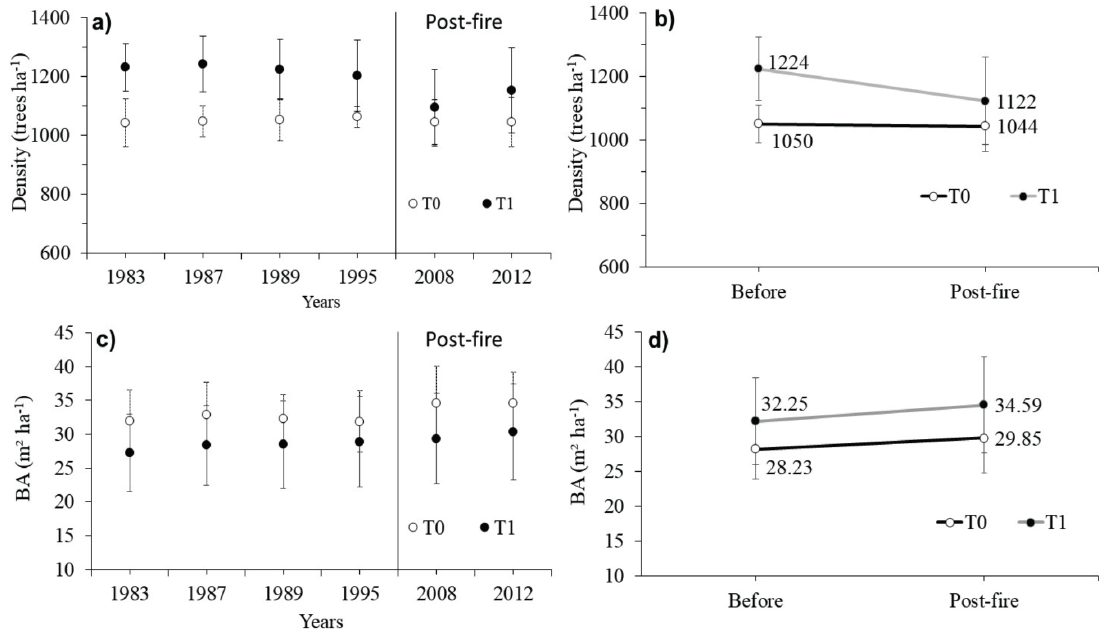
Figure 5 - Medium values of density ( a ) and difference between the means of density of before and after fire ( b ) and mean values of basal area ( c ) and difference between basal area averages before and after fire ( d ) in all measurements, in the 29 years of monitoring, for affected by fire (T1) and not affected by fire (T0) plots, in an dense ombrophylous forest, with no history of logging, in the Floresta Nacional do Tapajós, Pará State,